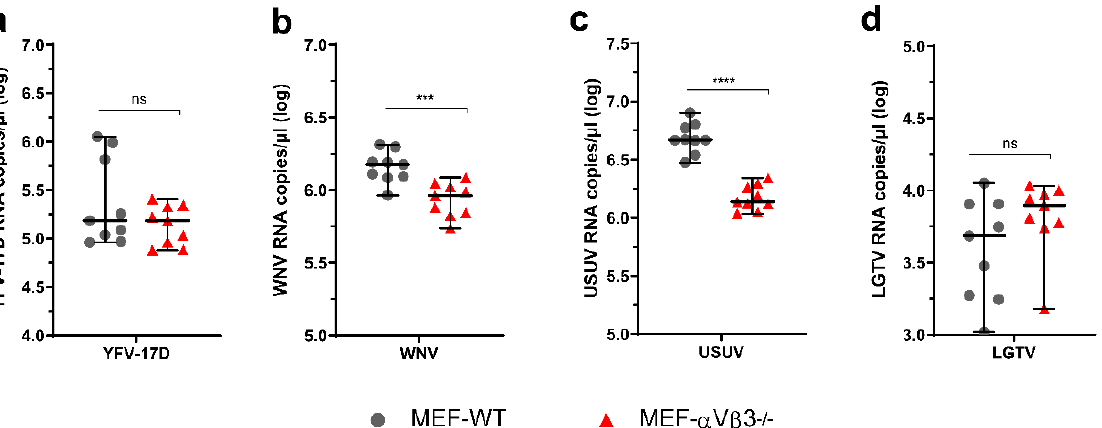
Figure 4. Internalization of ( a ) YFV-17D, ( b ) WNV, ( c ) USUV and ( d ) LGTV by MEF-WT and MEF- α V β 3 − / − . Cells were inoculated with different flaviviruses on ice for 1 h to allow virus binding but not internalization. Thereafter, cells were extensively washed and shifted to 37 °C for 30 min to allow virus internalization. Cell monolayers were treated with acidic glycine (pH 2.5) for 2 min to inactivate non-internalized virus. Monolayers were harvested, the amount of internalized virus was determined by RT-qPCR and expressed as copy numbers per microliter (log transformed). Three independent experiments were performed in triplicate each. Dot plots represent each individual replicate from the three independent experiments. Statistical analysis: Unpaired Student’s t-test with Welch’s correction; (***) p ≤ 0.001; (****) p ≤ 0.0001; ns: not significant ( p > 0.05).